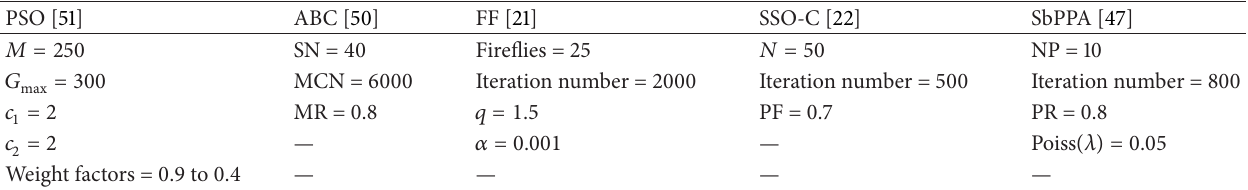
Weight factors = 0.9 to 0.4